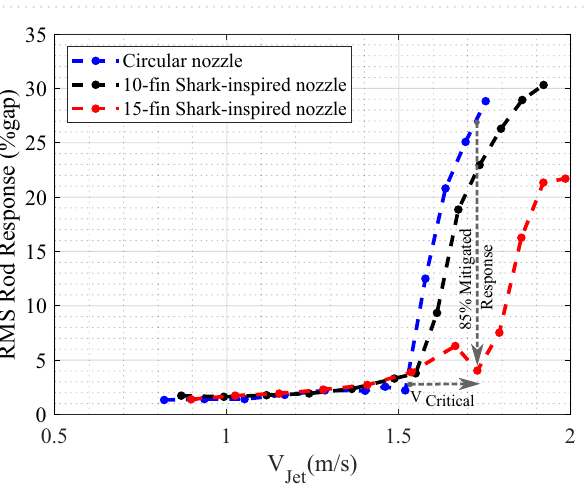
Figure 10. Rod bundle vibrations using 15 fins shark-inspired nozzle.